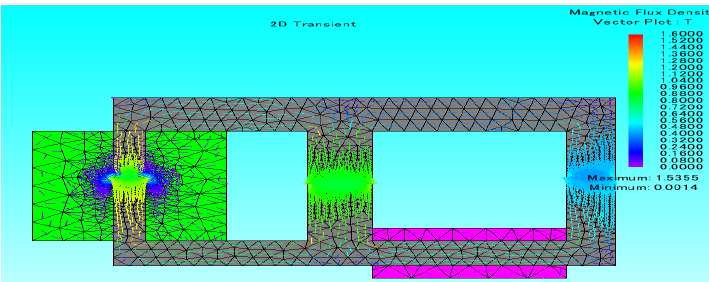
Figure 7. JMAG example of magnetic flux density